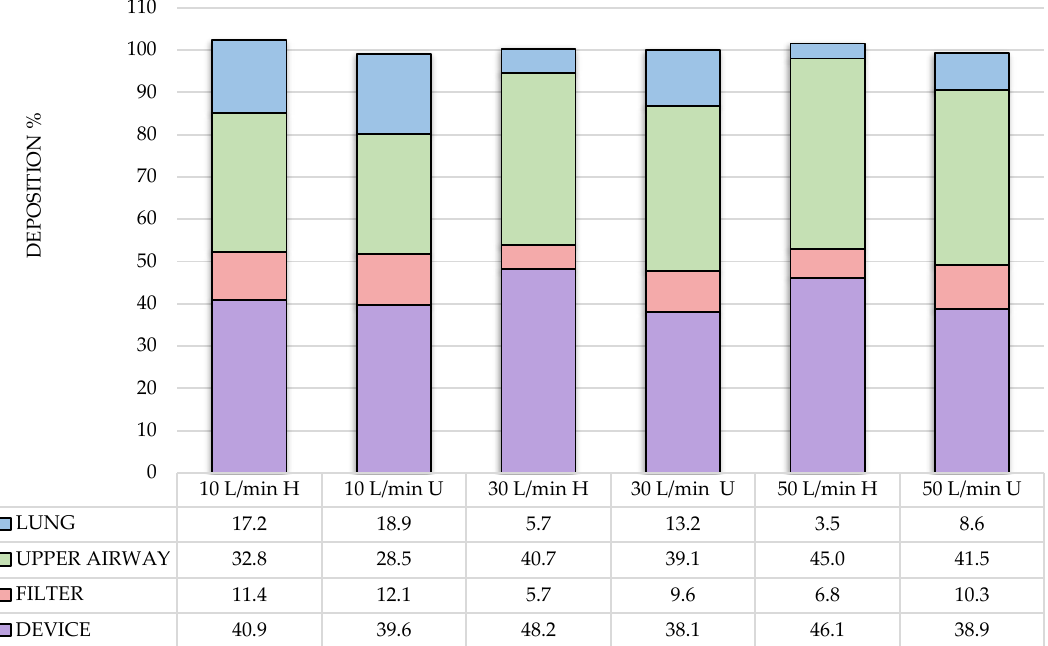
Figure 4. Aerosol distribution across compartments with LF and HFNC during heated humidified (H) and unheated (U) at flows of 10, 30, and 50 L/min.